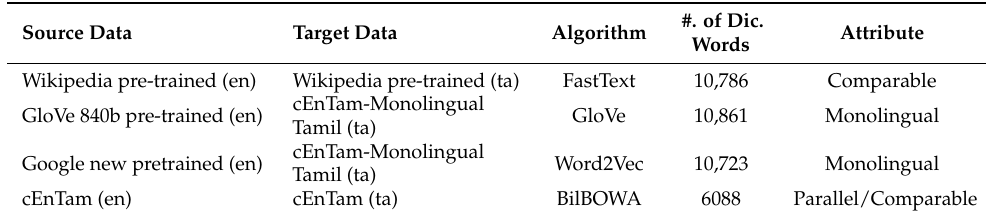
Table 1. Dataset descriptions and dictionary